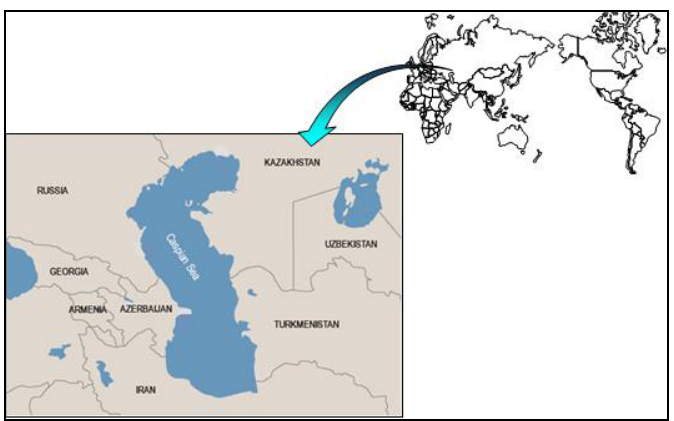
Figure 1. Caspian Sea’s and its five littoral states.